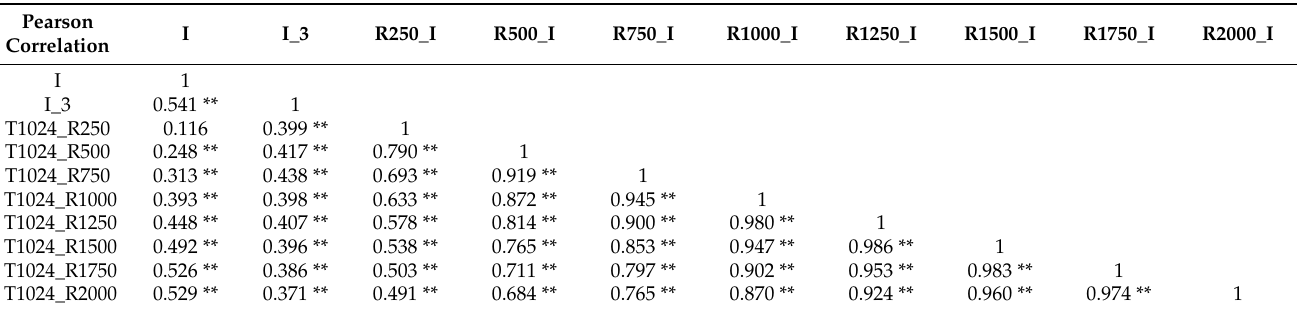
Table 5. Accessibility indicator correlation analysis.